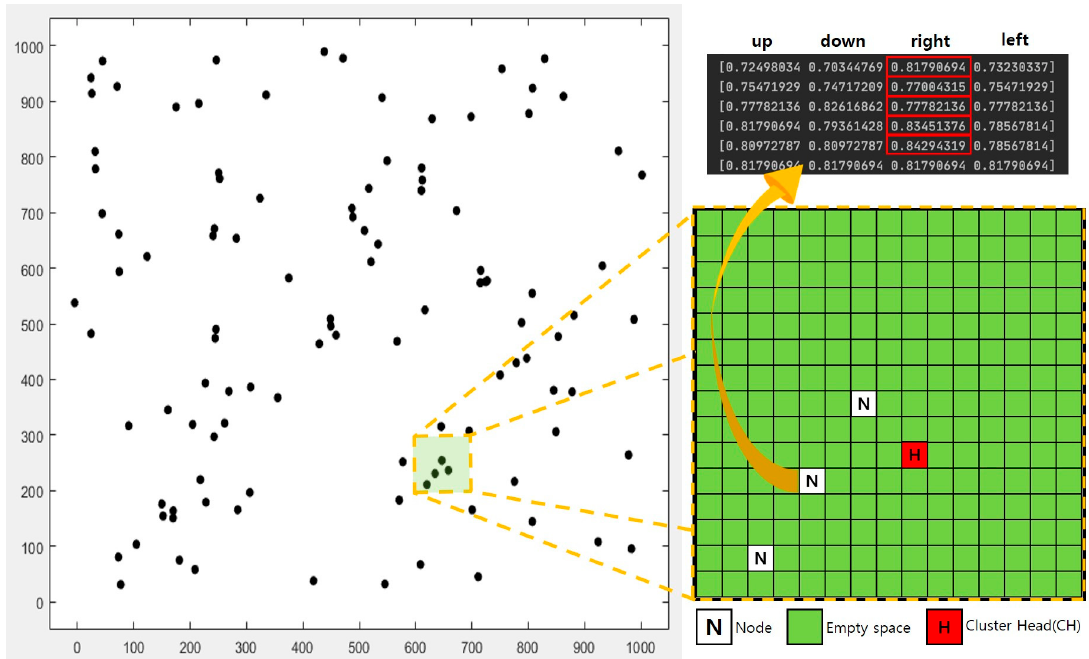
Figure 7. Q-LEACH: Target matrix from original topology and Q-table probability.